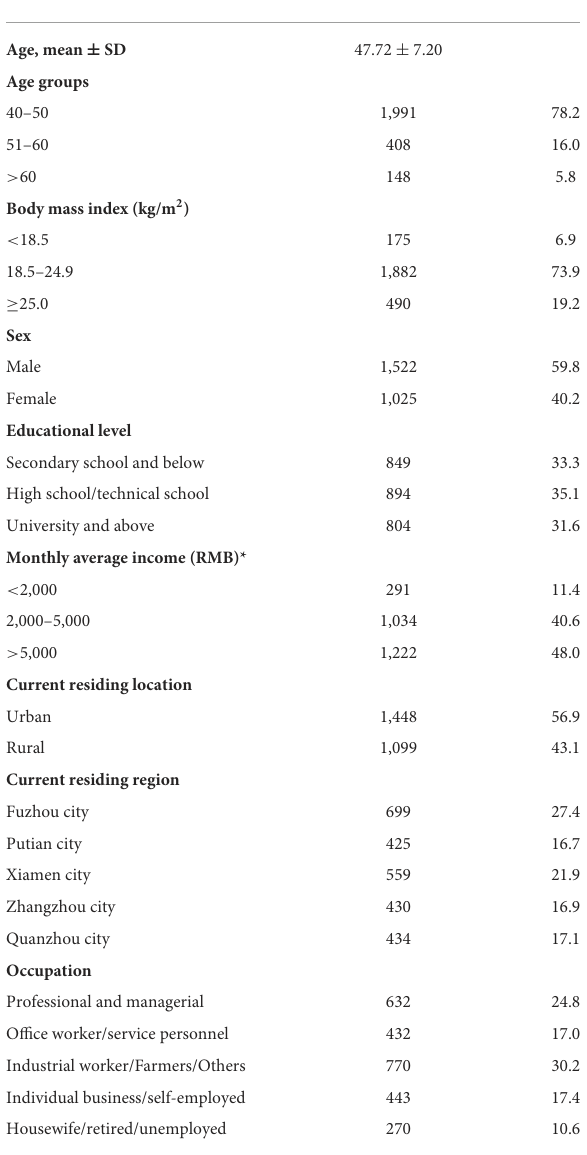
TABLE 1 Demographic characteristics of respondents ( N =